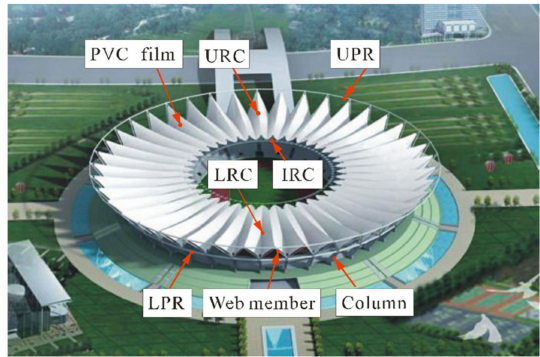
Figure 1. Aerial view of Foshan Century Lotus Sports Center (FCLSC).